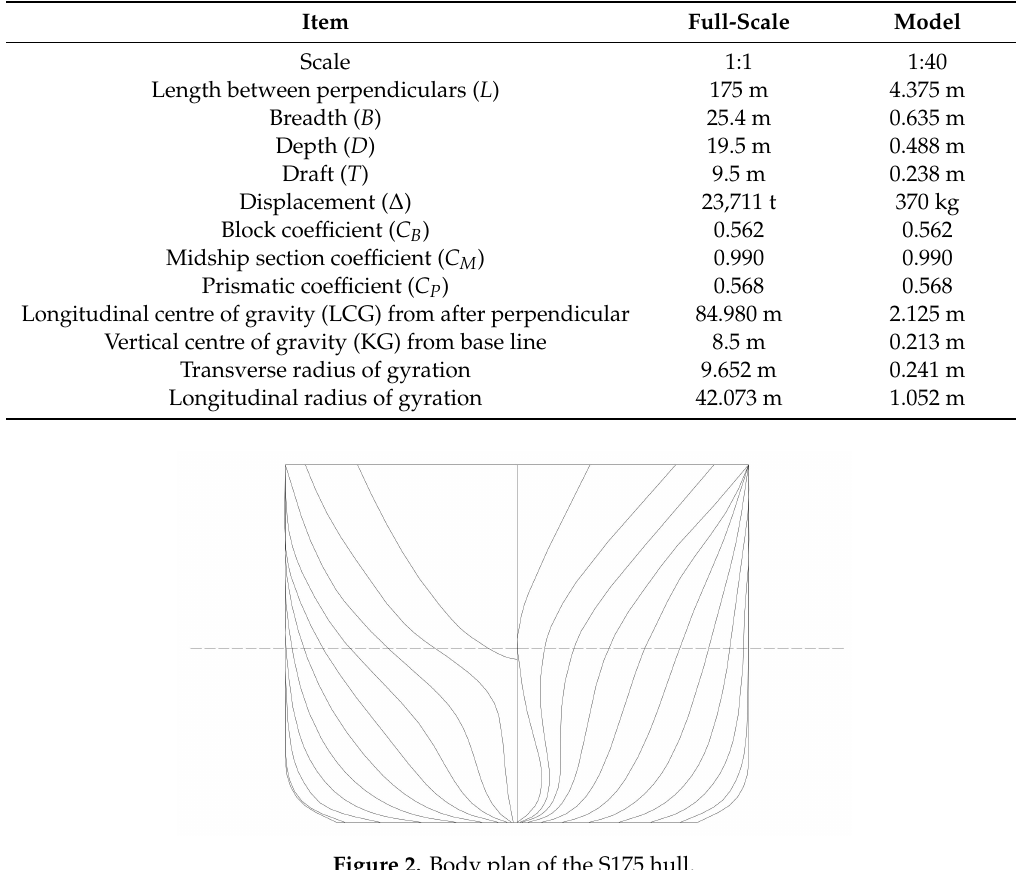
Figure 2. Body plan of the S175 hull.